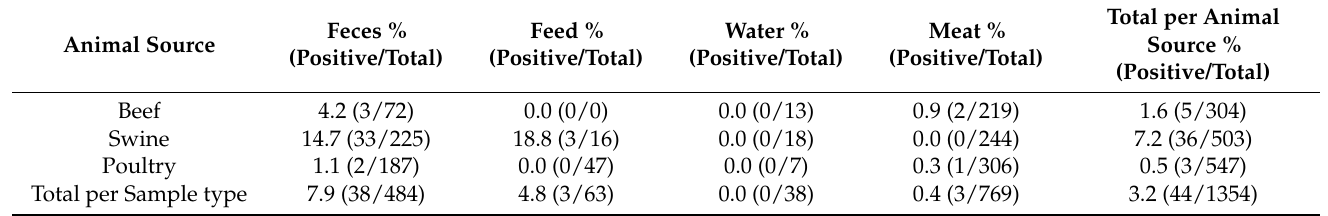
Table 3. Proportion of RT-PCR presumptive mcr -positive isolates by animal source and sample type 1